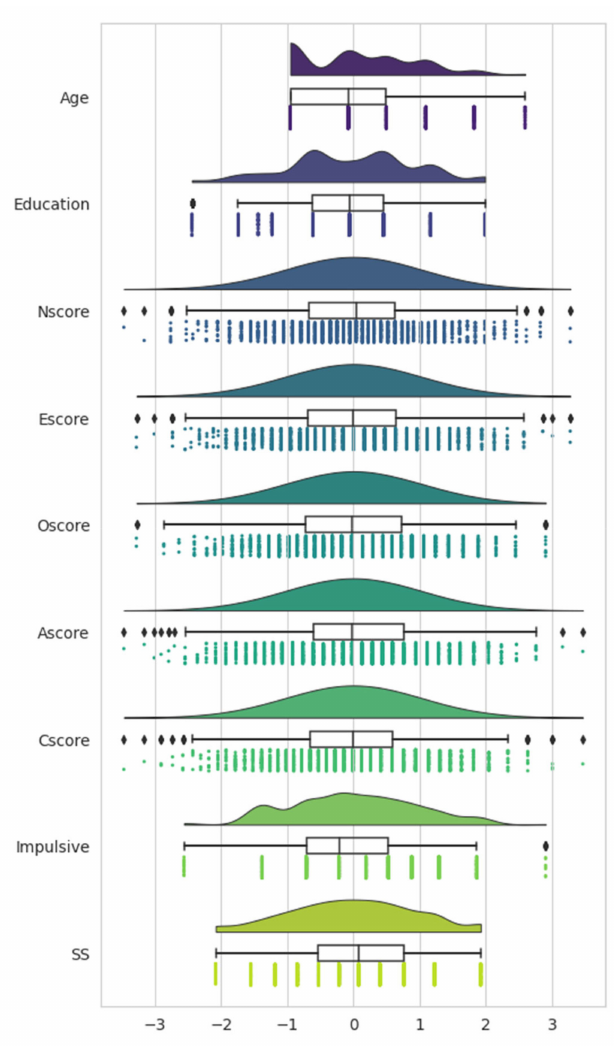
Figure 2. Distribution of quantified ordinal